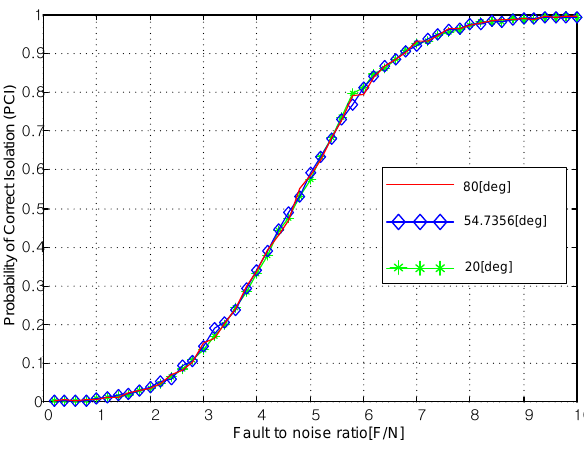
Figure 3 PCI for various cone angles from the center axis with n =